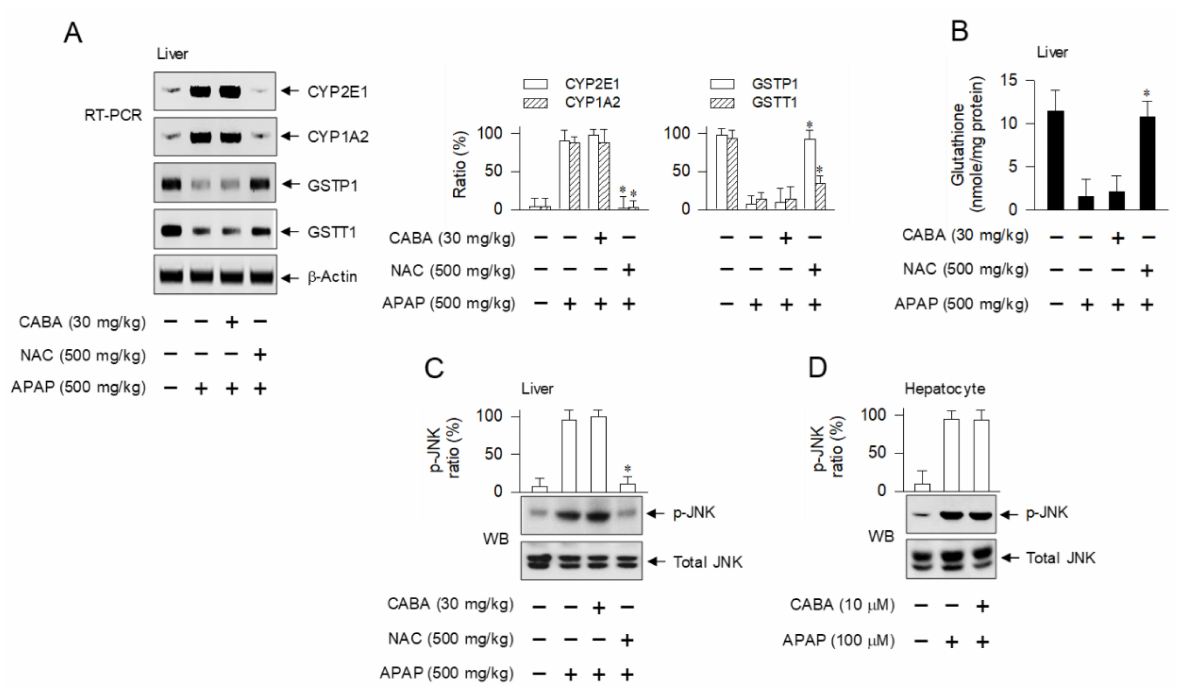
Figure 8. Effect of CABA on APAP-induced oxidative stress in the liver. C57BL/6 mice were treated with CABA at 1 h after APAP overdose. Liver lobules were biopsied at 15 h. ( A ) Total RNAs were subjected to RT-PCR analysis of CYP2E1, CYP1A2, GSTP1, or GSTT1 with internal control β -actin. ( B ) Cell extracts was subjected to ELISA to determine the levels of glutathione, which were normalized to mg of protein. ( C ) Protein extracts were subjected to Western blot (WB) analysis with anti-p-JNK or anti-JNK antibody. ( D ) Primary hepatocytes were pretreated with CABA for 2 h and stimulated with APAP for 12 h in the presence of CABA. Protein extracts were subjected to WB analysis with anti-p-JNK or anti-JNK antibody. Ratio (%) represents the relative intensity of signals in the WB. * p < 0.05 vs. APAP